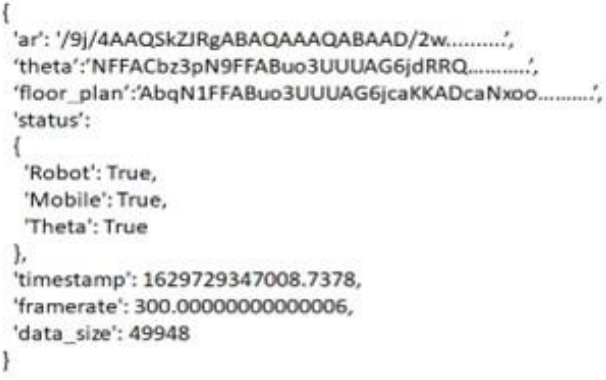
Figure 9. User interface of the developed prototype.